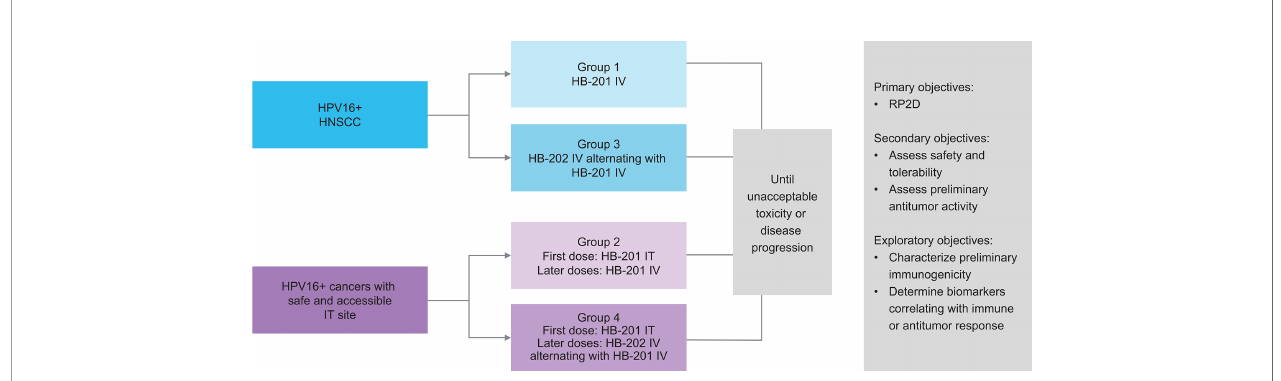
FIGURE 2 | Design of ongoing phase 1/2 study of HB-201 in patients with previously HPV+ cancers, including HNSCC (3, 42). a 3 + 3 dose escalation with additional biomarker- and schedule- fi nding cohorts. b All injections consist of speci fi ed vector monotherapy. HNSCC, head and neck squamous cell carcinoma; HPV, human papilloma virus; IT, intratumoral; IV, intravenous; q2w, every 2 weeks; q6w, every 6 weeks; RP2D recommended phase